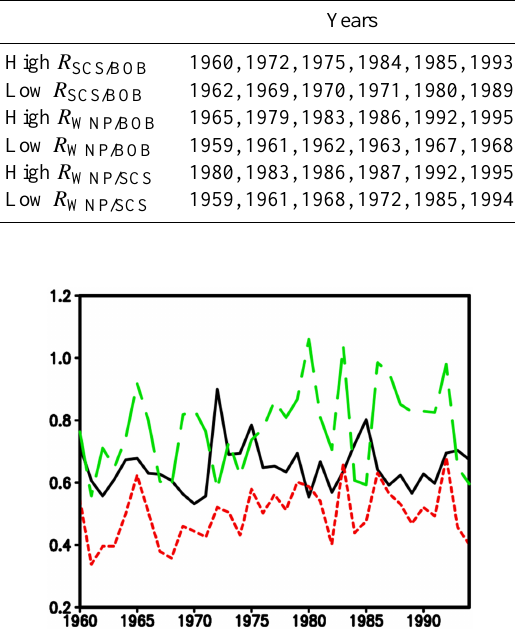
Figure 4. The time series of R SCS/BOB (solid line; black), R WNP/BOB (short dotted line; red), and R WNP/SCS (long dotted line; green) from 1960 to 1994.